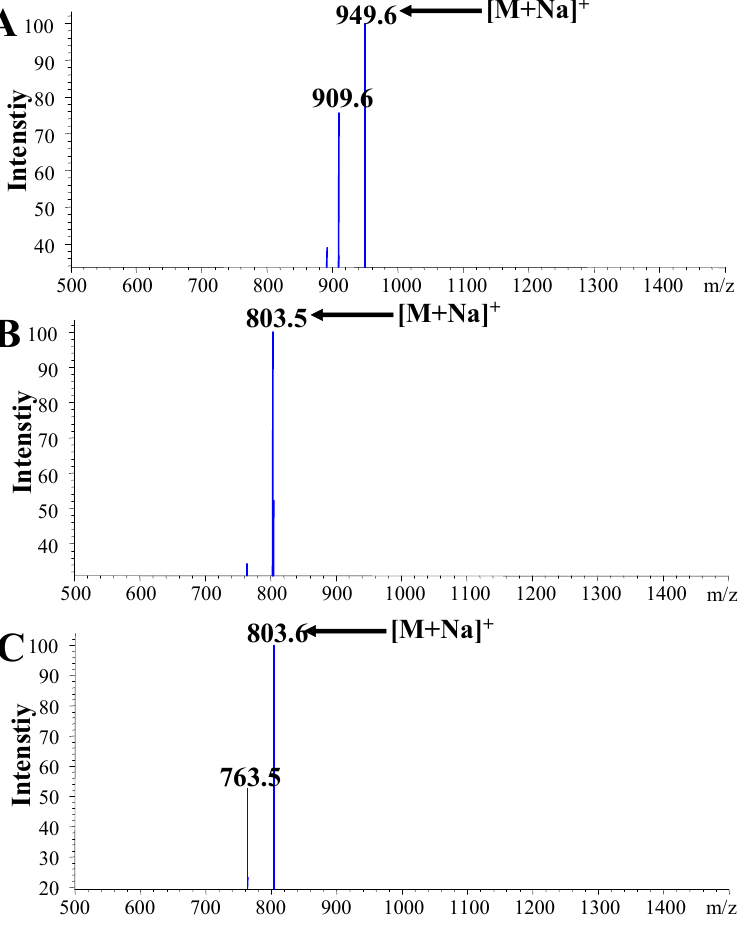
Figure 5. ESI/MS (+) spectra of saikosaponin c (A); saikosaponin a (B); saikosaponin d (C).